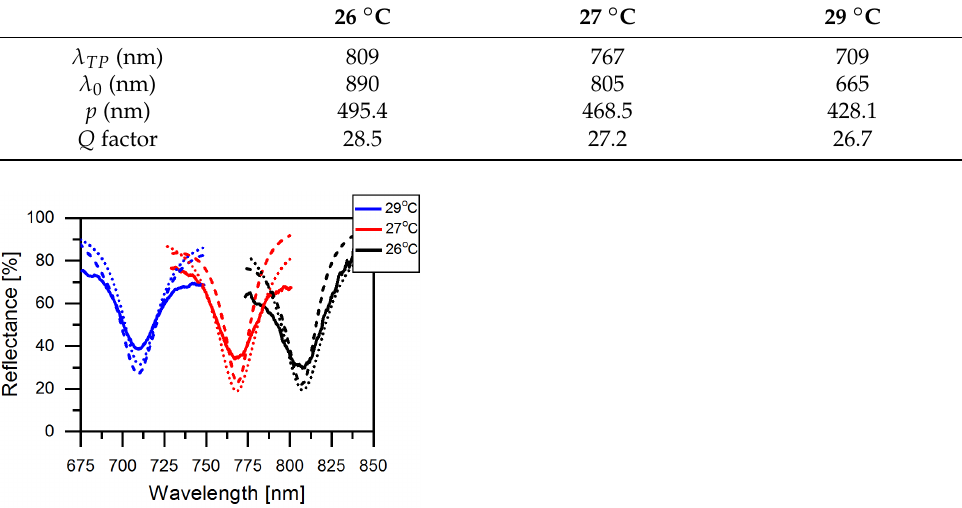
Figure 6. Reflectance spectra of the CLC–metasurface simulated by Berreman method (dotted lines); COMSOL (dashed lines) and experiment results (solid lines) by increasing the temperature from 26 ◦ C to 29 ◦